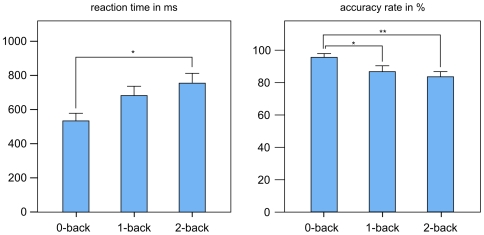
Reaction times and accuracy rate.Reaction times (mean±standard error) and accuracy rate (percentage of correct answers, mean±standard error) of 25 subjects. Asterisks denote where pair-wise comparison is significant.